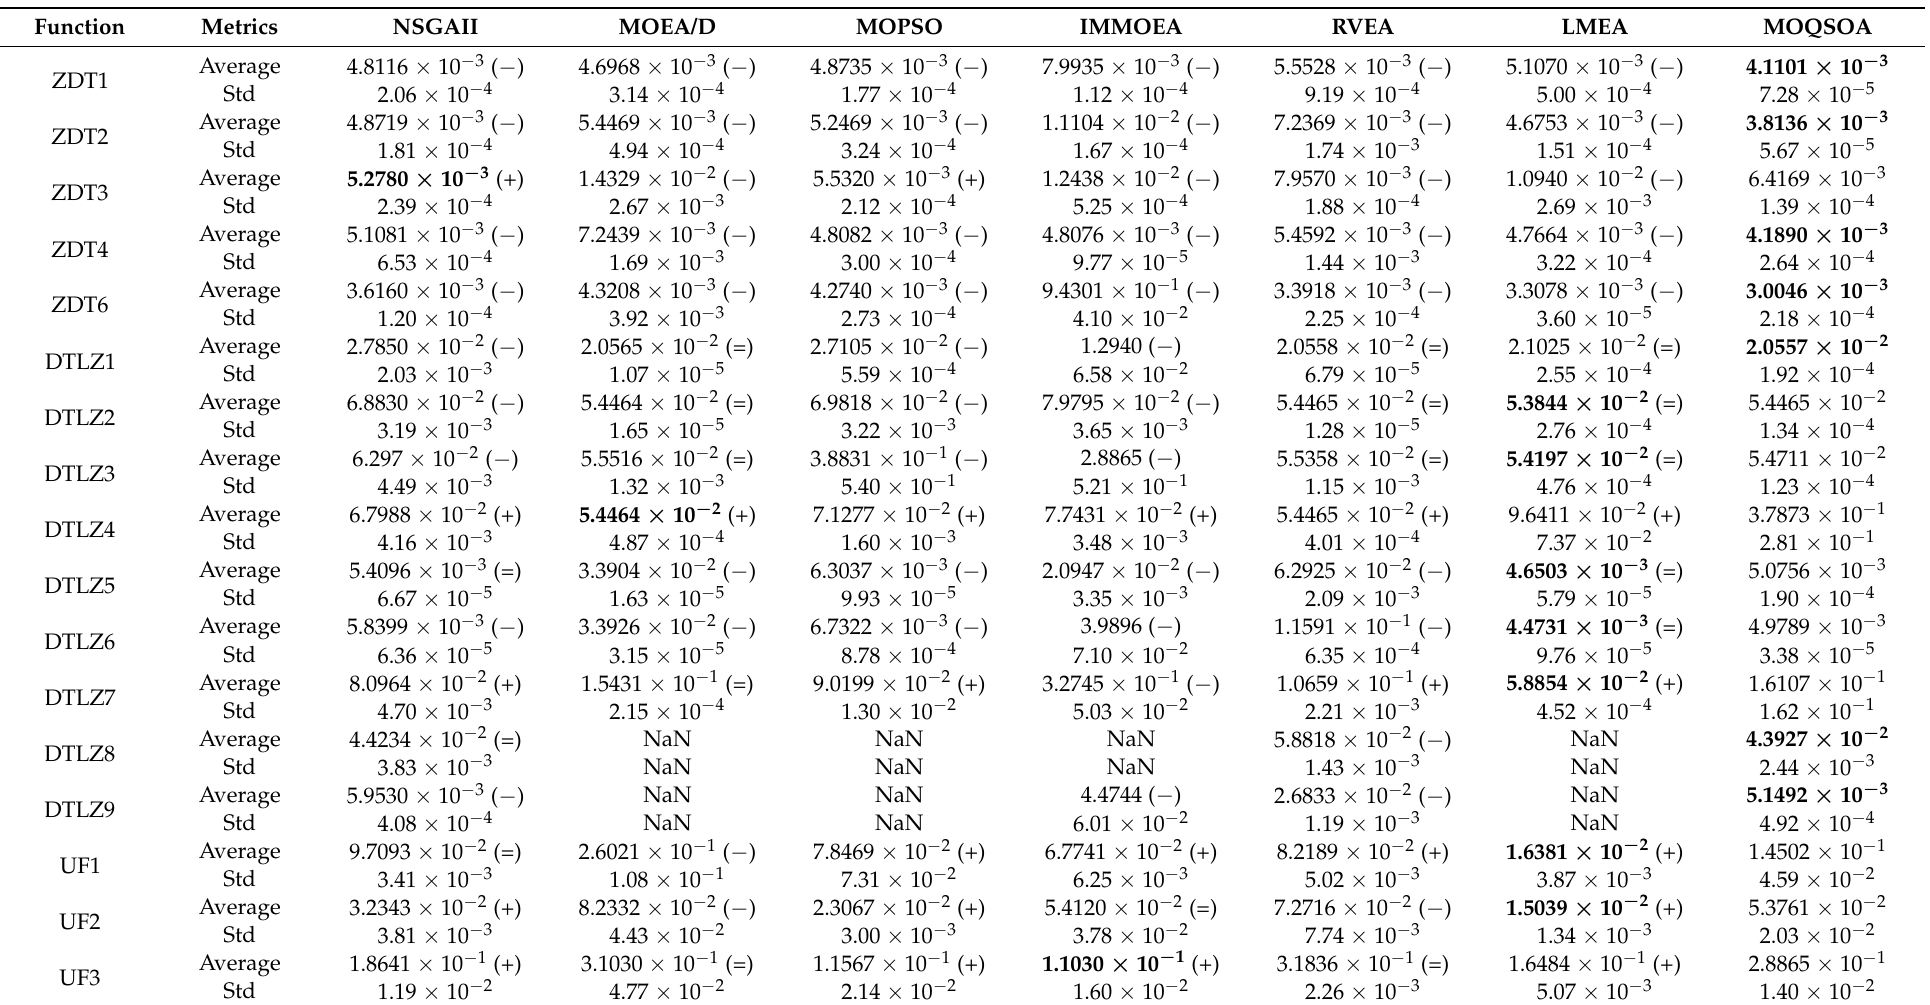
Table 3. IGD metric